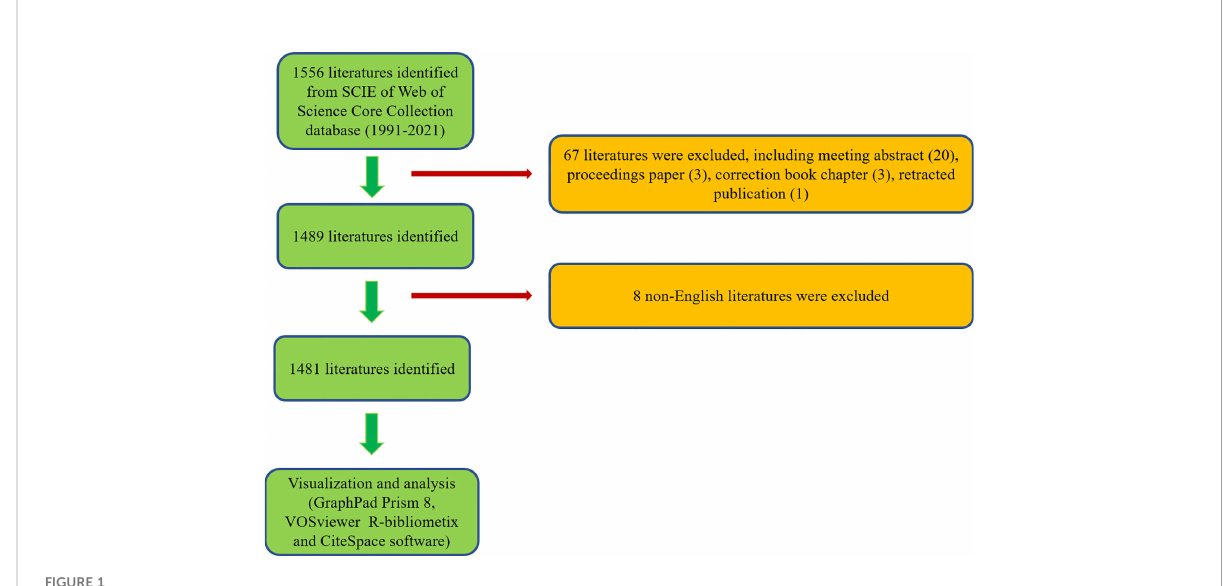
FIGURE 1 Flowchart of the screening